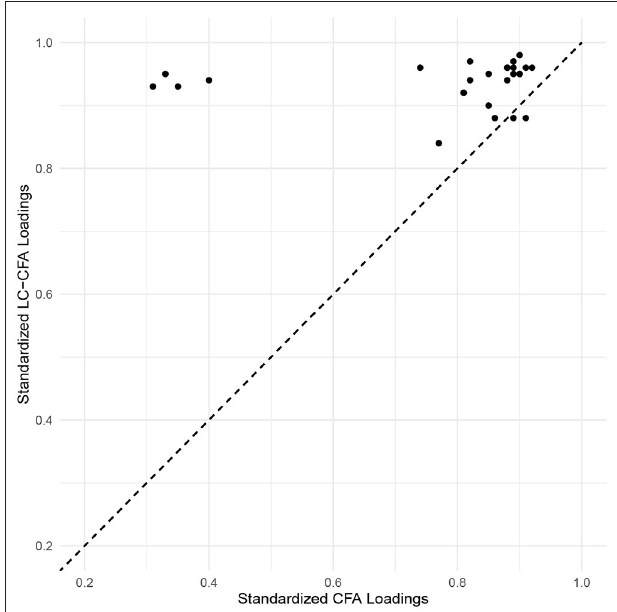
FIGURE 4 | Scatter plot of loading estimates from the LC-CFA and traditional CFA. Values above the diagonal (dashed) line indicates higher standardized loadings for the LC-CFA. The reverse coded items are in the top left part of the